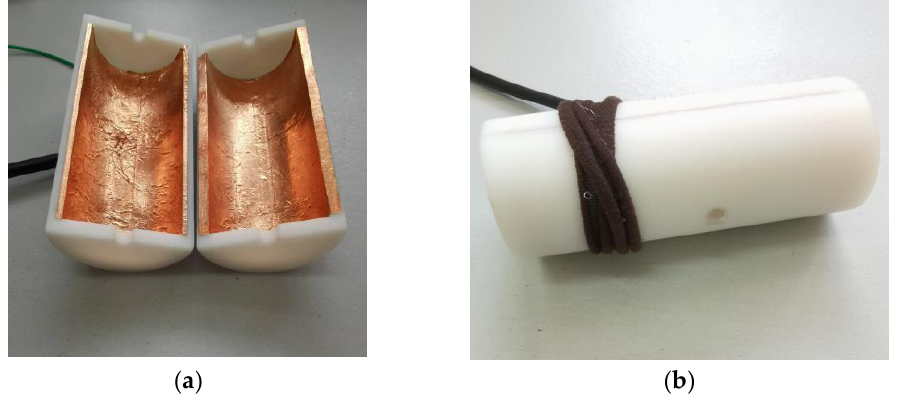
Figure 8. Physical diagram of probe: ( a ) schematic diagram of internal structure of probe; ( b ) schematic diagram of external structure of probe.